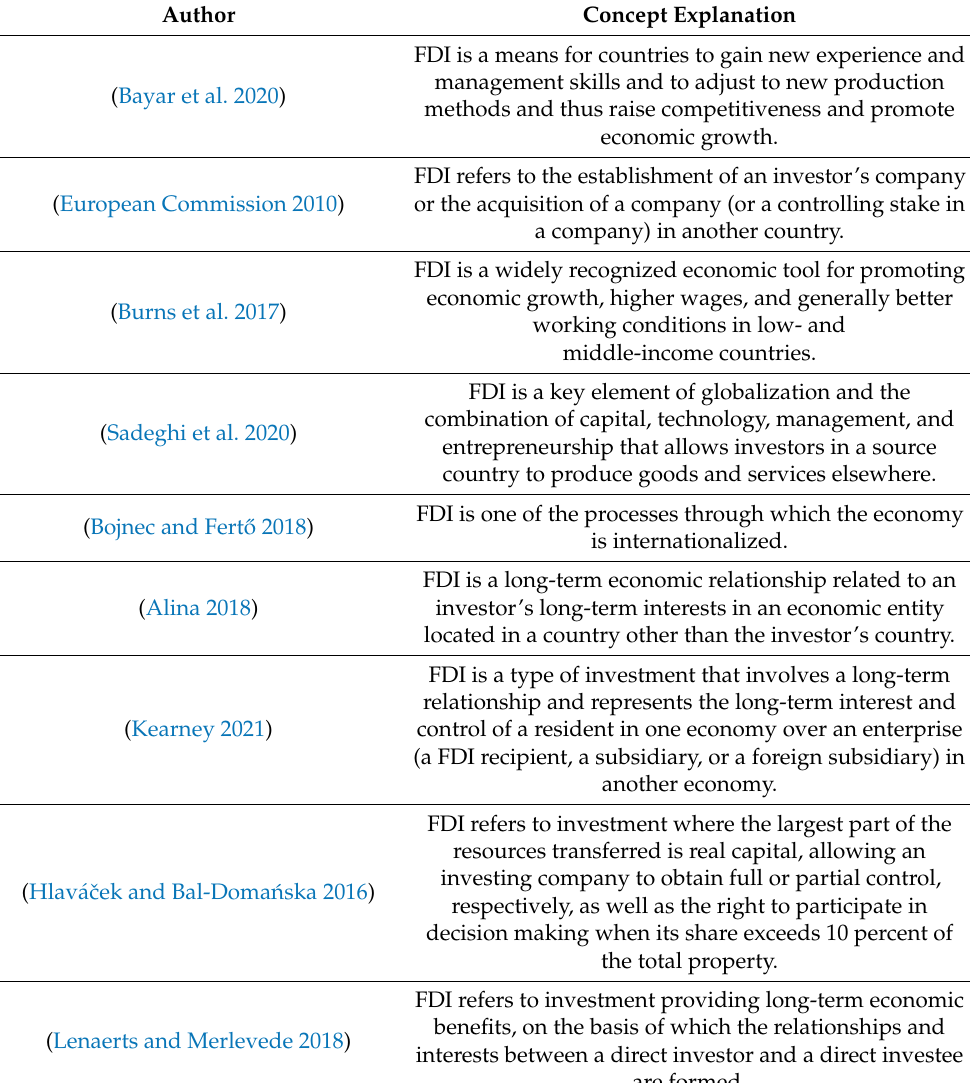
Table 1. FDI concept